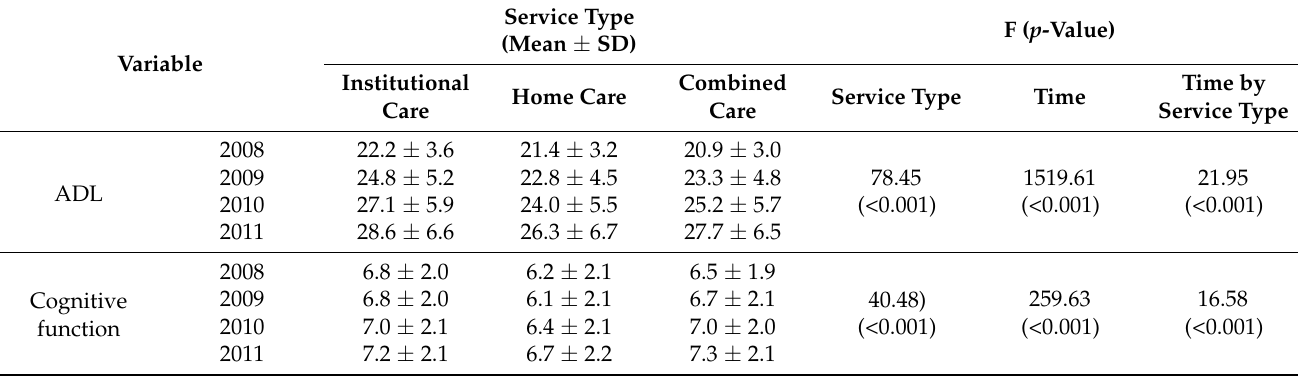
Table 3. ADL, cognitive function, medical cost, and benefit-cost in LTCI beneficiaries according to service type and time.